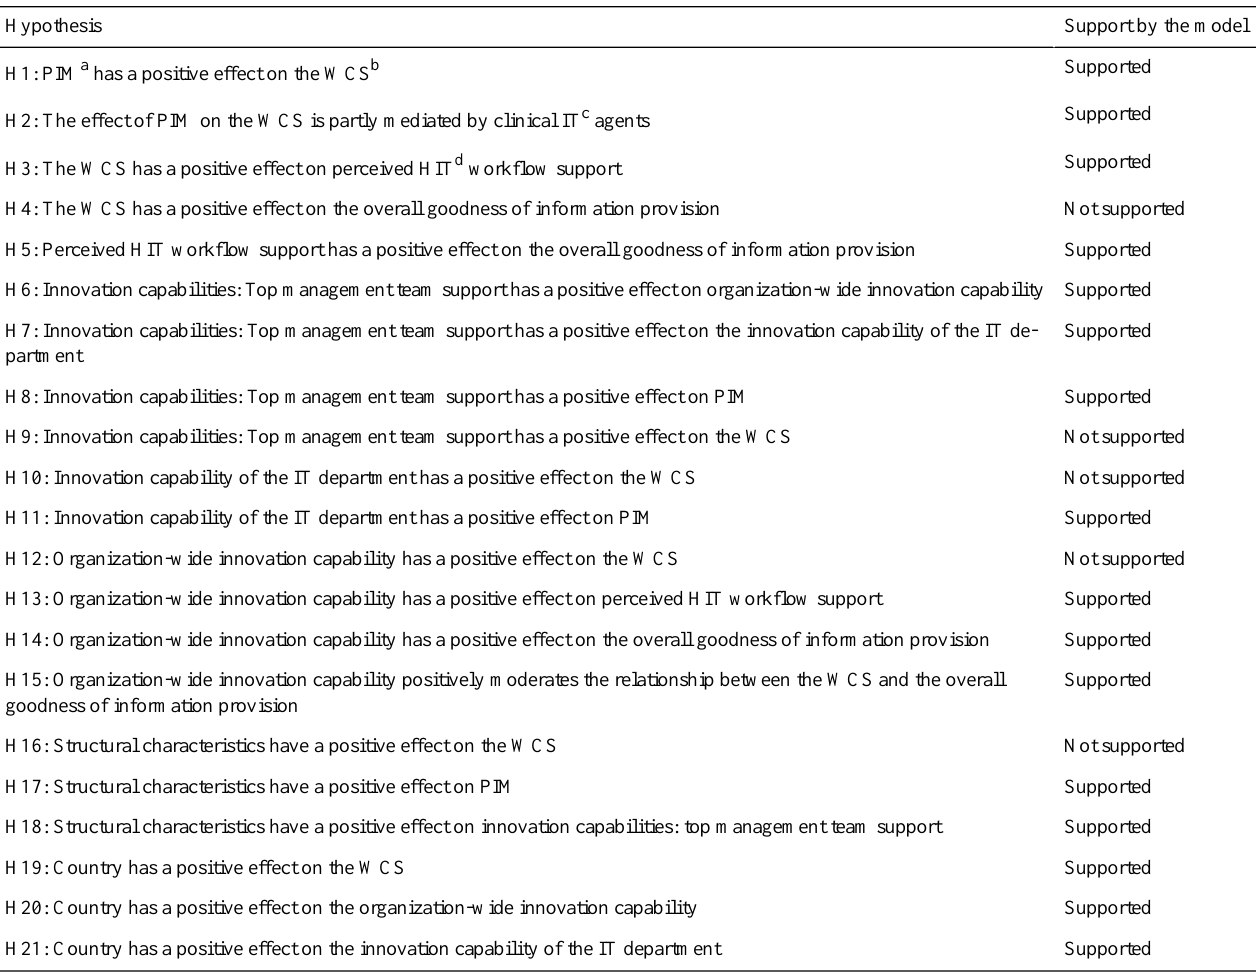
Table 4. Summarized results of the hypothesis tests in reference to P values <.05.